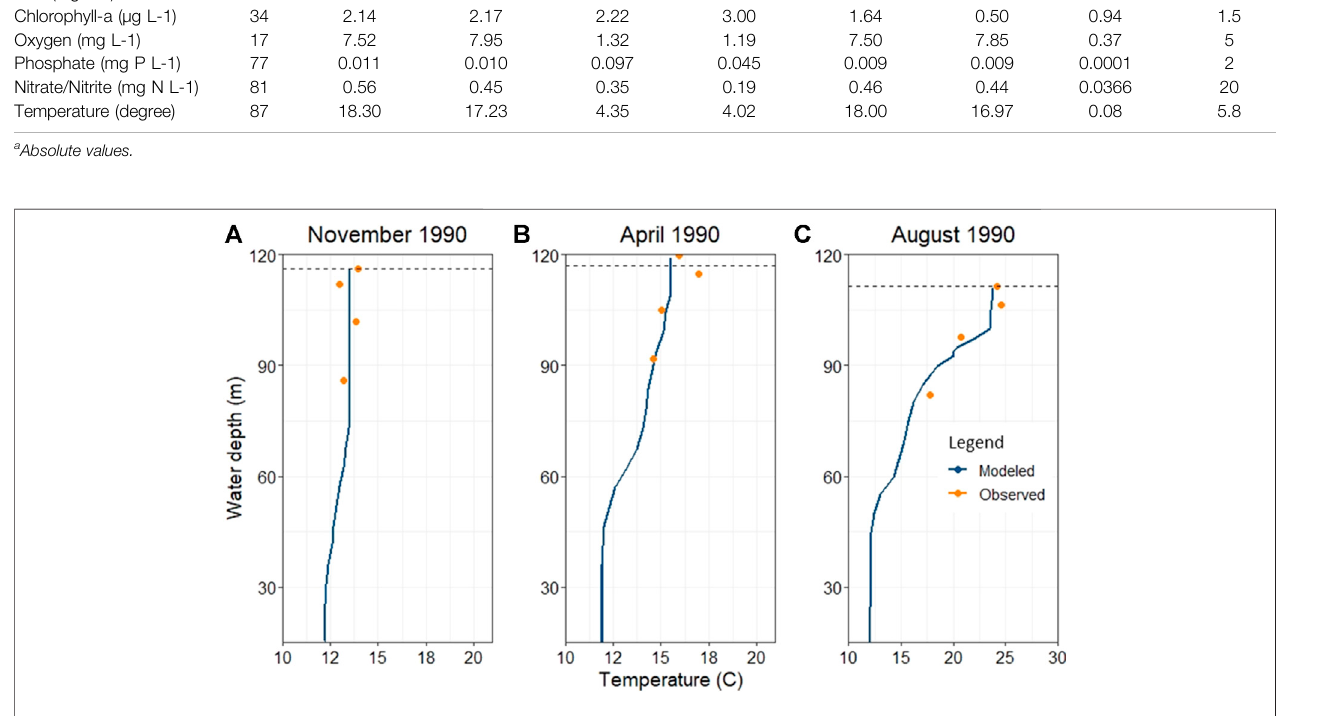
Frontiers in Environmental Science |